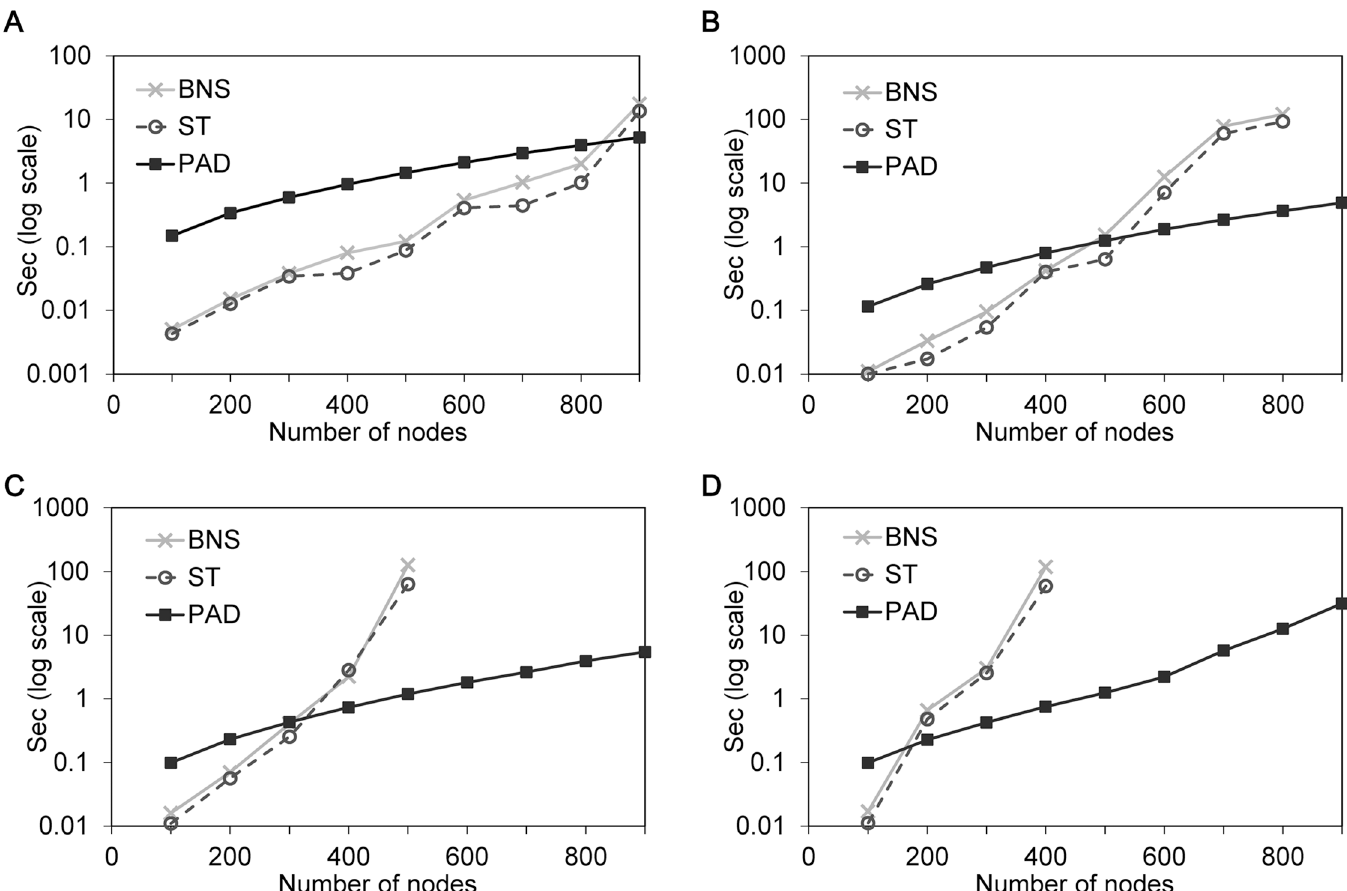
Fig 4. Runtime comparisions of algorithms. The simulation results for 3,600 randomly generated Boolean networks (BN) with maximum indegree K . Each dot is the median value computed for 100 networks. A: Median runtime of algorithms for BN with K = 2. B: Median runtime of algorithms for BN with K = 3. C: Median runtime of algorithms for BN with K = 4. D: Median runtime of algorithms for BN with K =